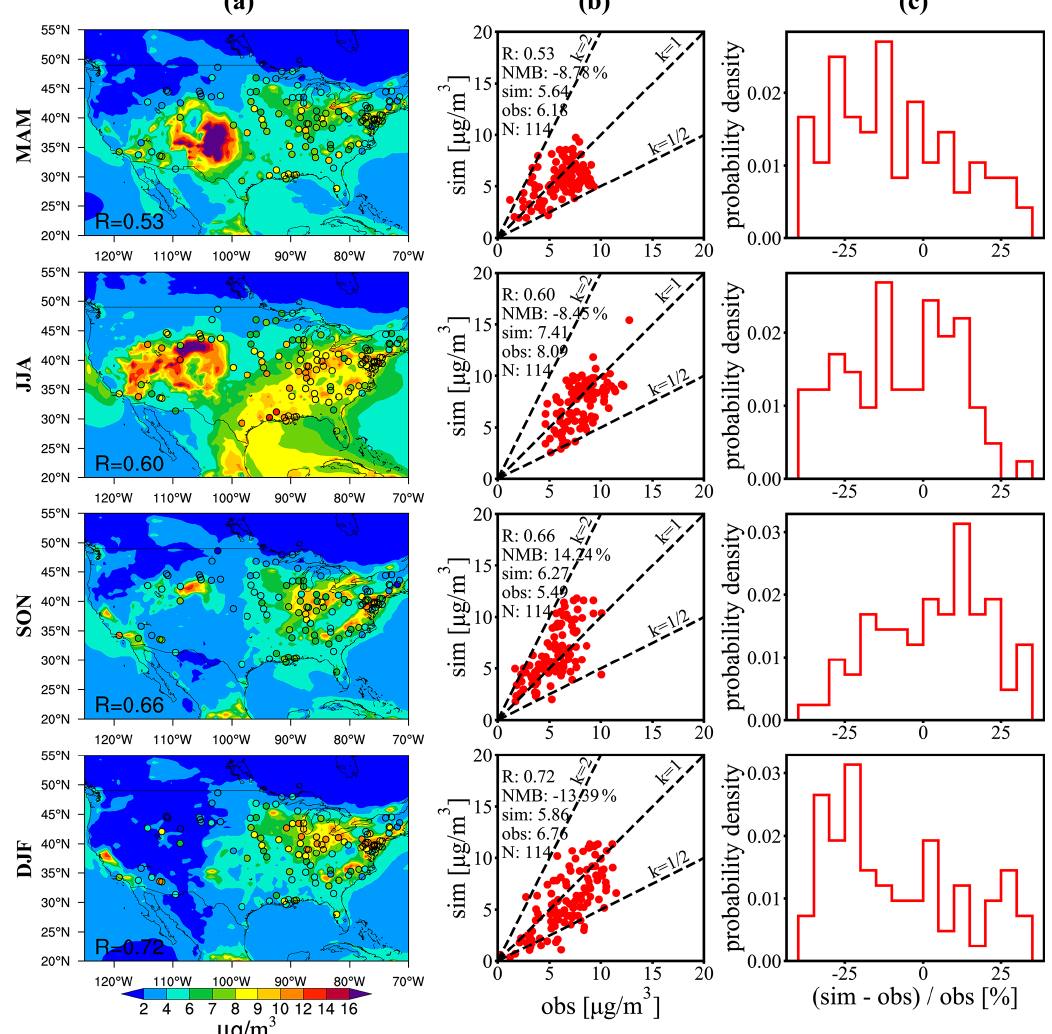
Figure 12. Same as Fig. 8 but in the United